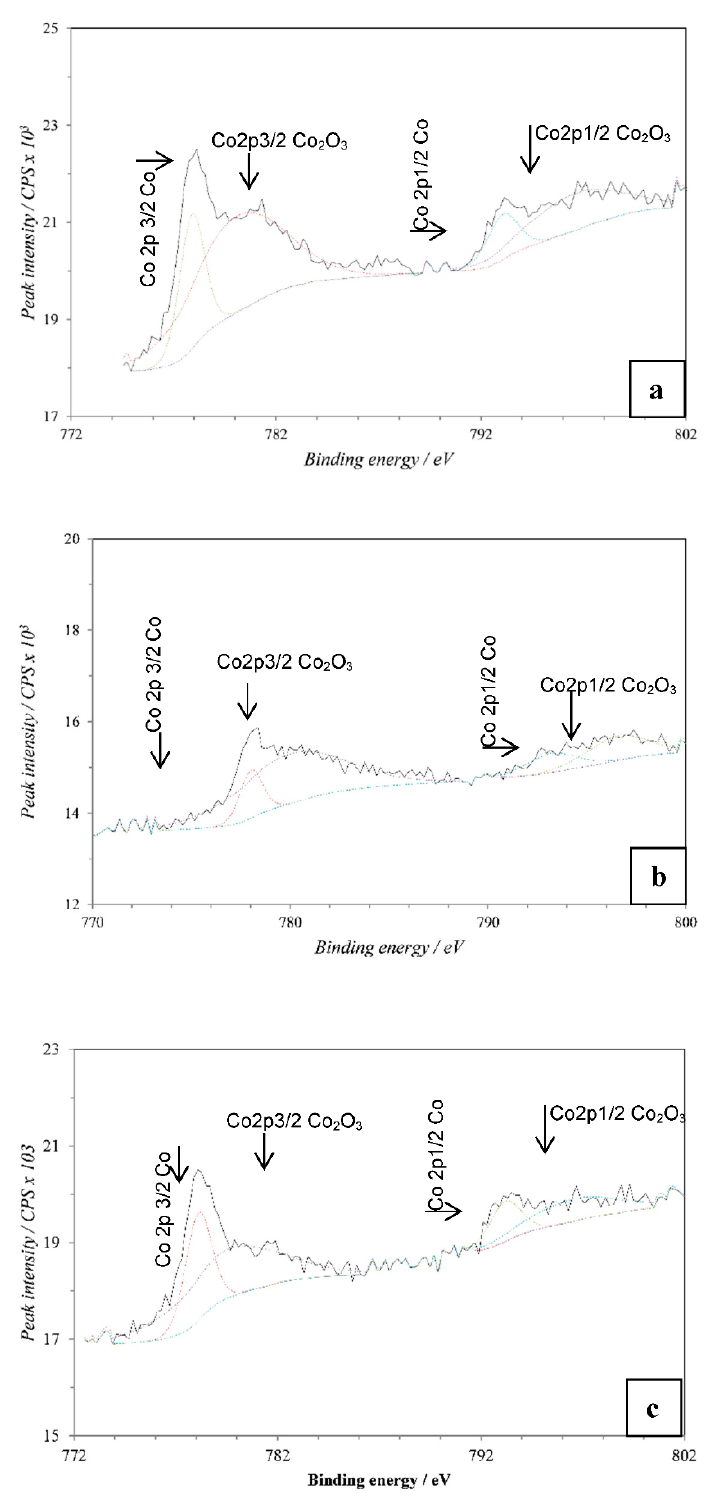
Figure 14. High resolution spectra of Co 2p peaks, ( a ) sample exposed for 24 h, ( b ) sample polarized to 100 mV and ( c ) sample polarized to 1000 mV before polarization,